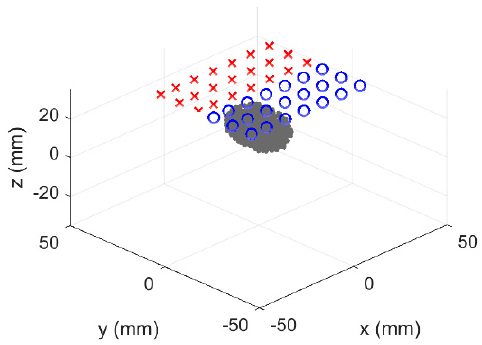
Figure 3. Simulated heterogeneous system. Blue circles and red crosses identify sources and detectors, respectively. The gray ellipsoid is the heterogeneity, which was varied in depth.